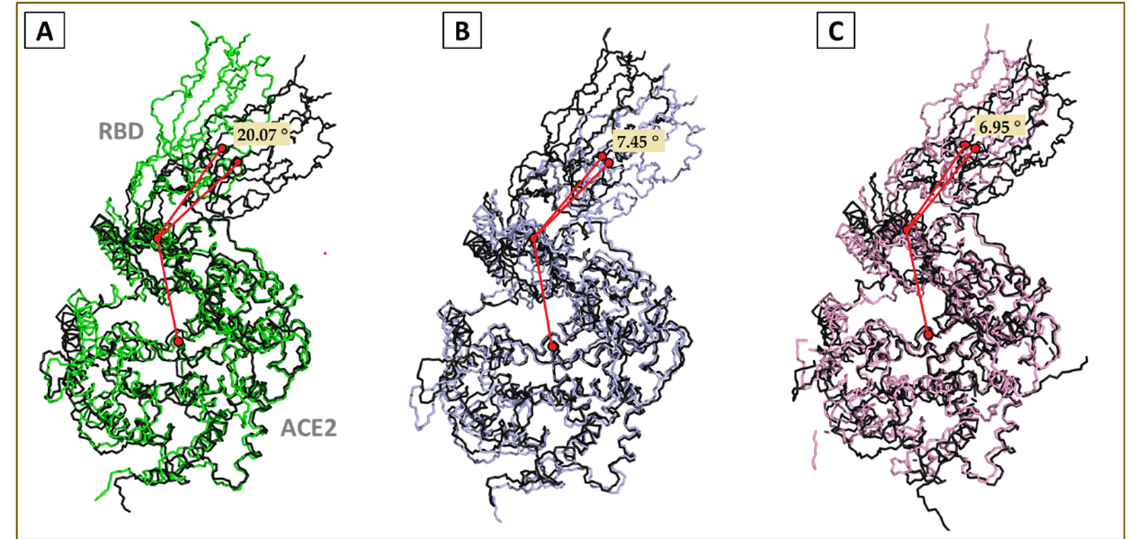
Figure 6. Characteristic relative angular twist of the ( A ) wtRBD–ACE2, ( B ) kRBD–ACE2, and ( C ) dRBD–ACE2 complexes.